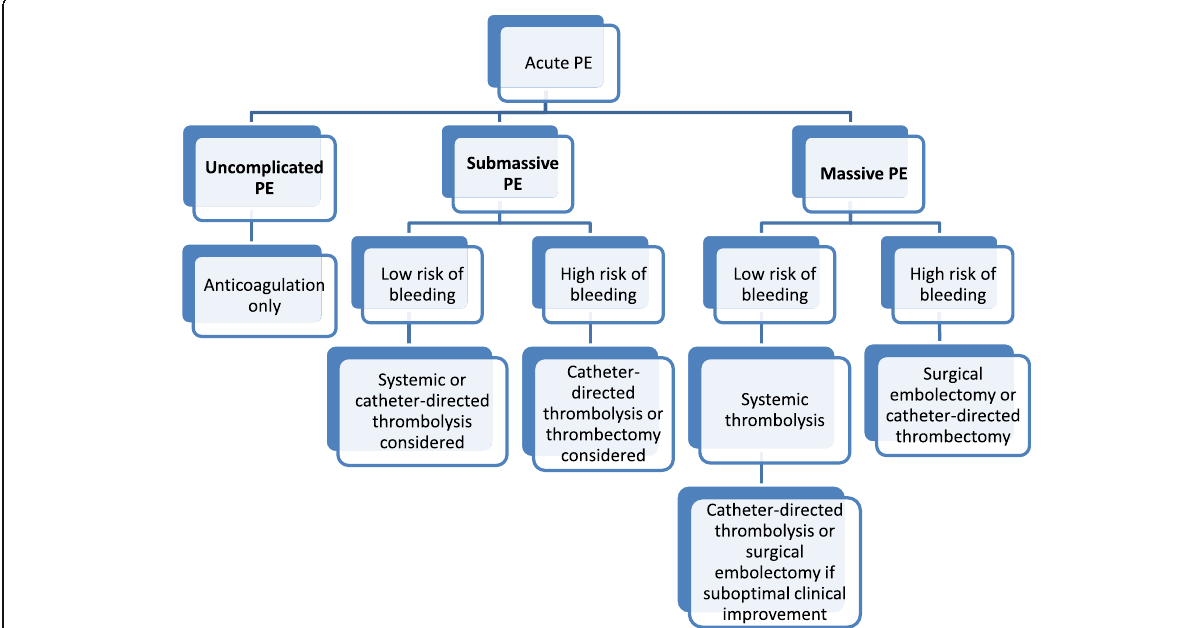
Fig. 10 Treatment algorithm for acute PE. Diagram demonstrates an algorithm for treatment of acute